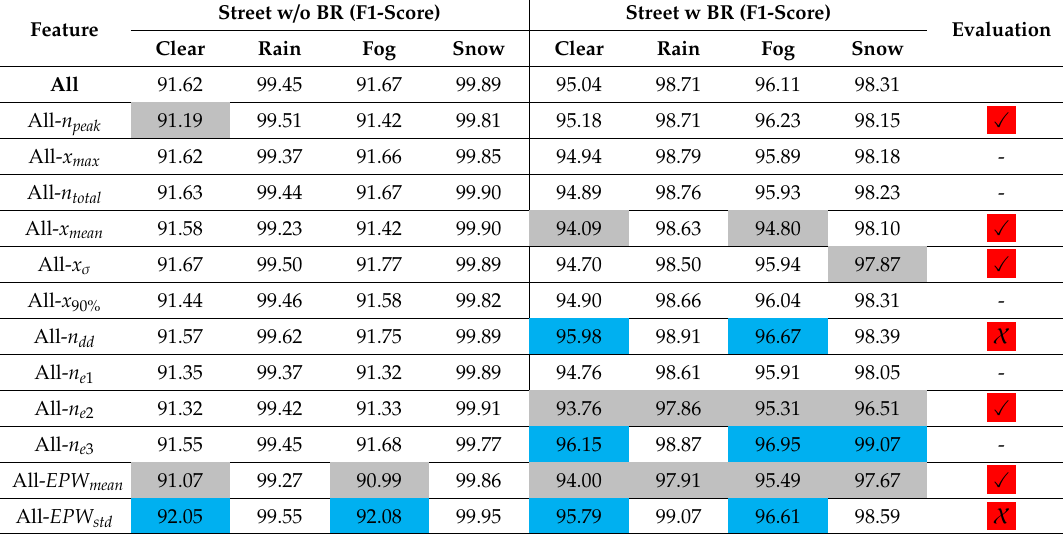
Table 8. Results of the feature ablation analysis for the atmosphere region using the F1-Score as evaluation parameter. In comparison with the score using all features the features are marked with (cid:88) when the F1-Score for two or more classes decreases more than 0.4 (marked in gray), with X when increases more than 0.4 (marked in blue) and with - in other cases.